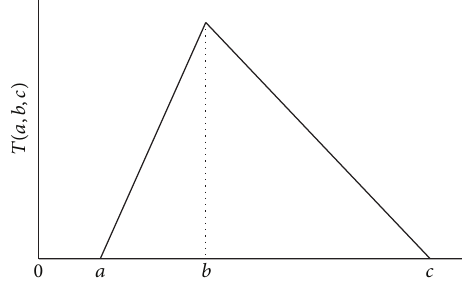
Figure 2: Triangular fuzzy